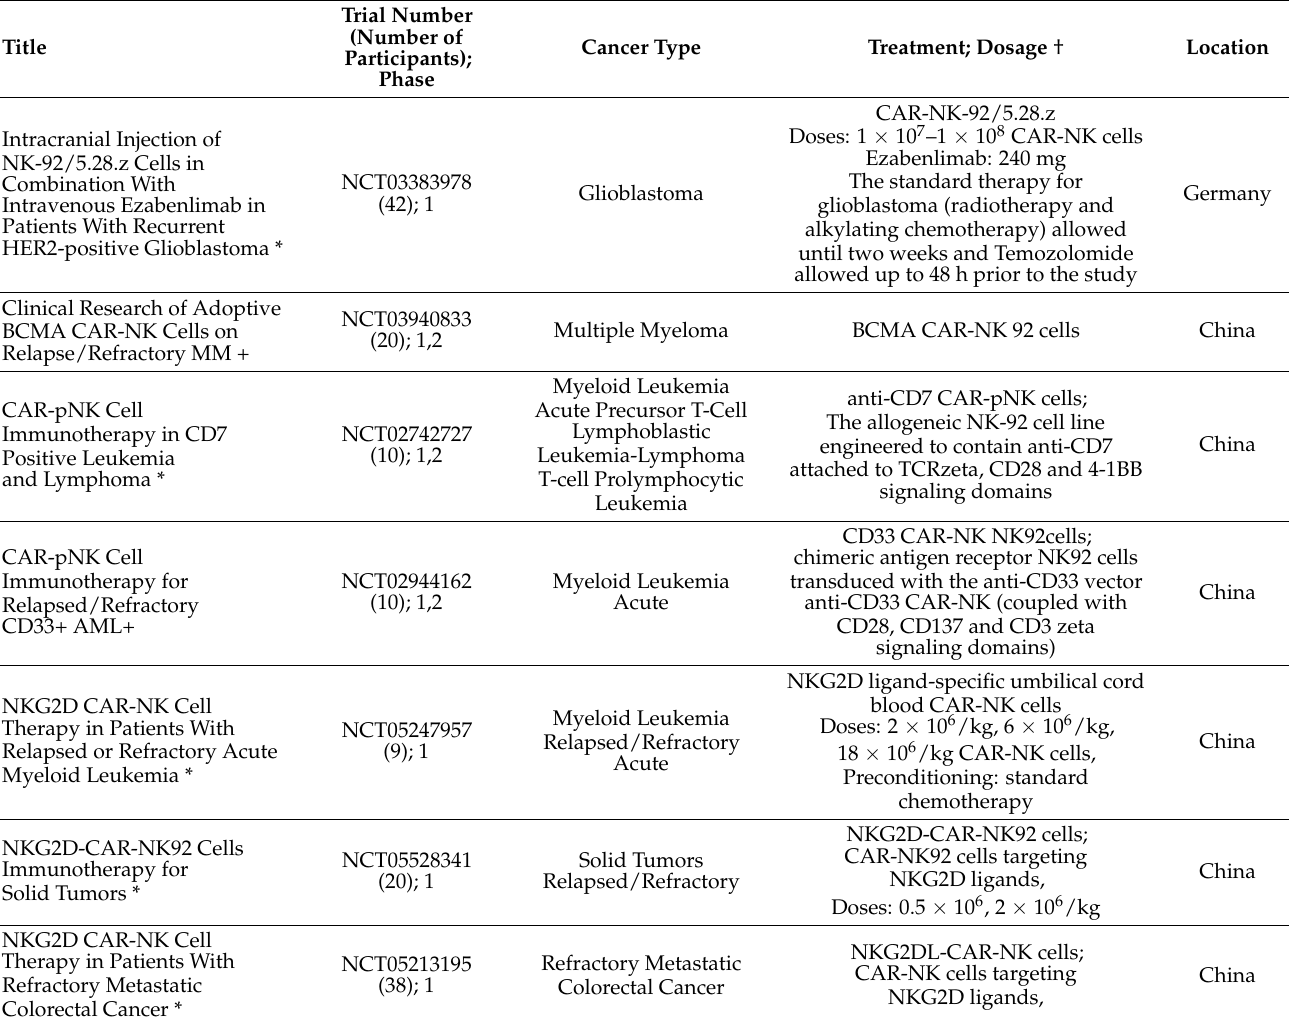
Table 1. The summary of currently registered clinical trials based on CAR-NK